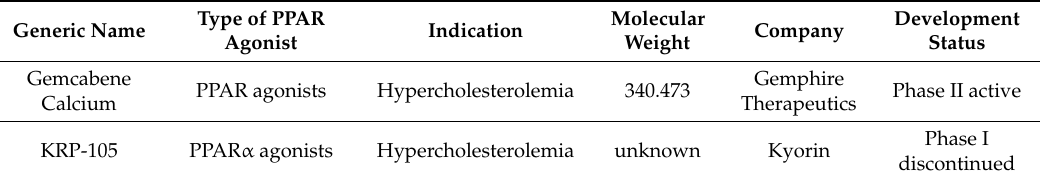
Table 11. Drugs of PPAR ligands for treatment of cardiovascular disease